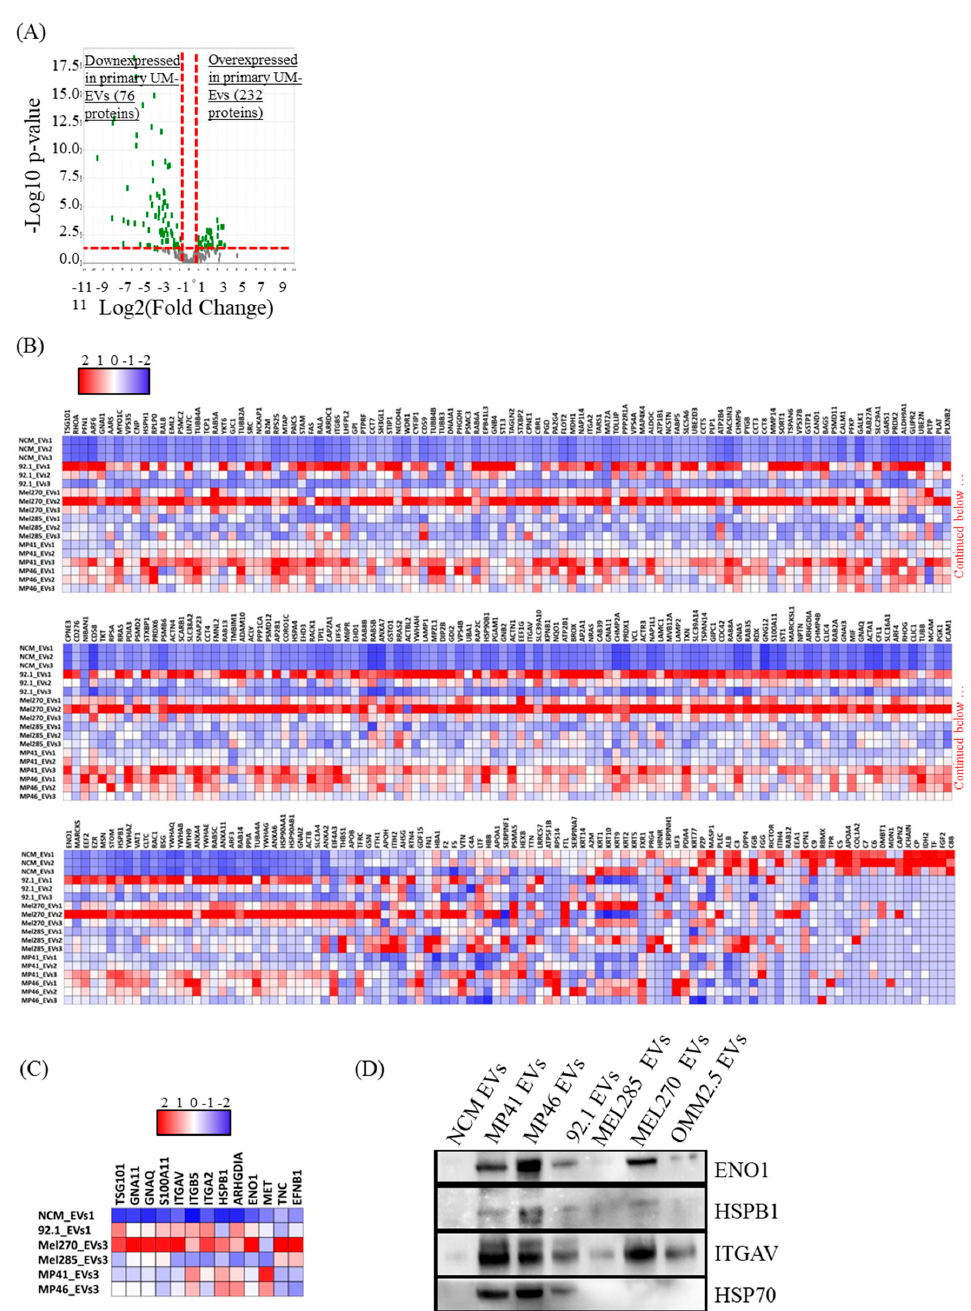
Figure 6. Primary UM-EVs are enriched in proteins involved in the regulation of tumor growth, homeostasis and metastasis organotropism. ( A ) Volcano plot representation of 308 proteins significantly and di ff erentially expressed between primary UM-EVs and NCM-EVs. ( B ) Heatmap chart representing the 308 di ff erentially expressed proteins. Note that primary UM-EV contents clustered differently from that of NCM-EVs. The full list of proteins is shown in Table S2. ( C ) Heatmap chart depicting the relative expression levels of proteins linked to tumorigenesis, cancer homeostasis, and metastasis organotropism. ( D ) Immunoblot validation of the relative expression levels of some proteins that emerged from MS data mining (see C ). Note: HSP90 shown (Figure S7 ( E )) was probed on a di ff erent membrane. In B , C , the key color represents Log(2) of protein quantitative ration where blue and red refer to downexpressed and overexpressed proteins in UM-EVs,